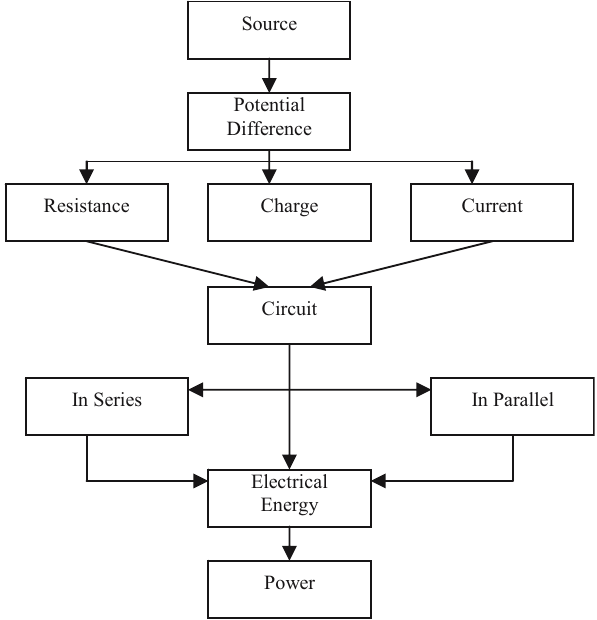
FIG. 1. The concept map drawn initially by the “From electro- statics to currents” group describing the central concepts involved in the transition from electrostatics to